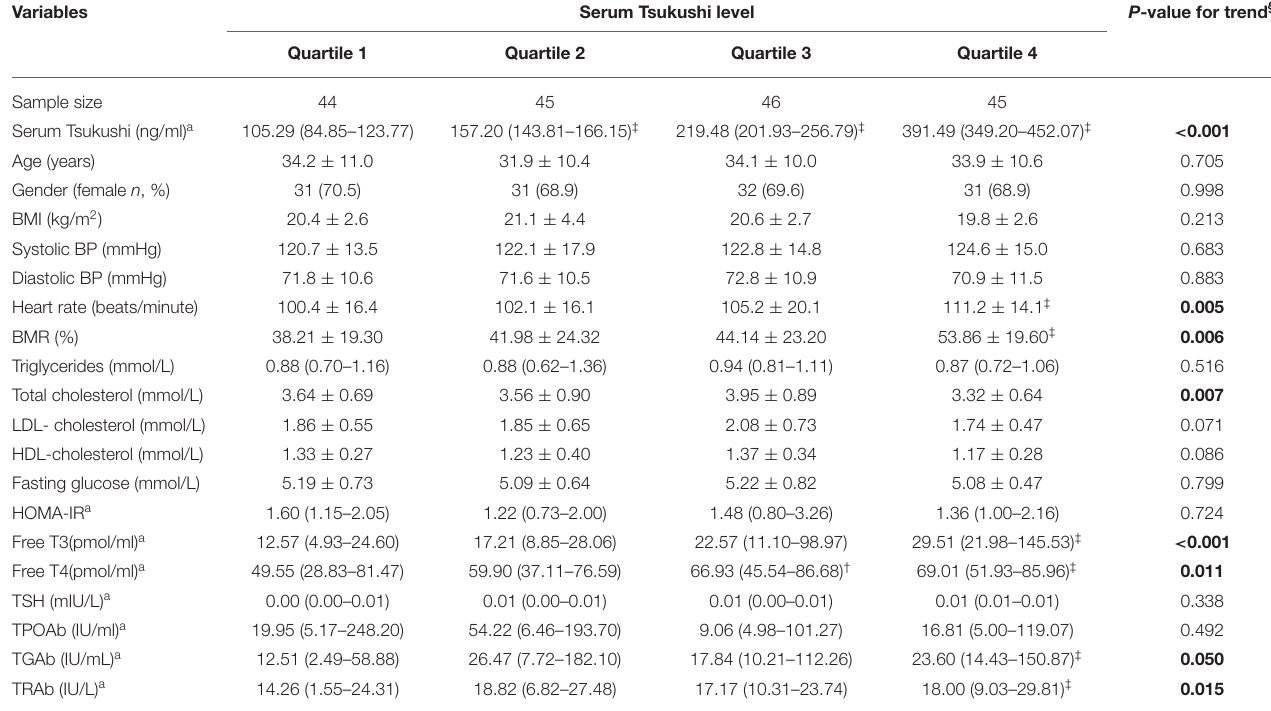
TABLE 2 | Clinical characteristics by quartiles of serum Tsukushi levels in hyperthyroid